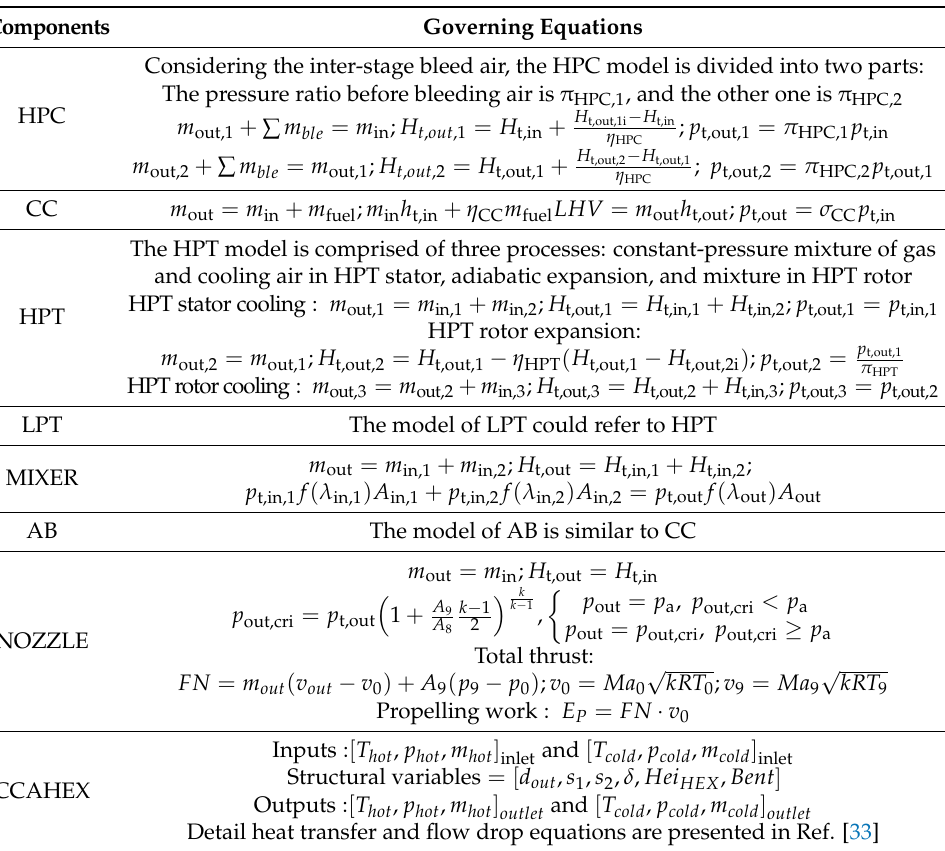
Table 3. Cont. Components Governing Equations